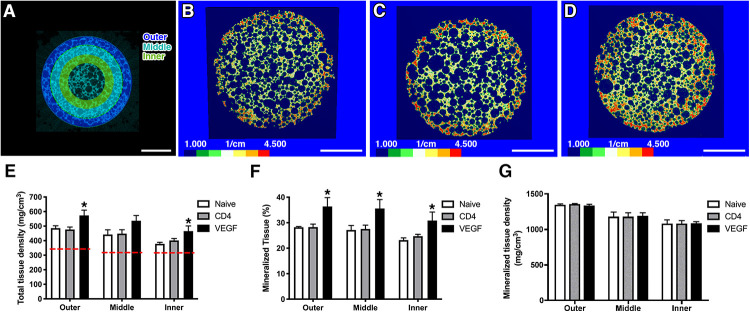
(A) For μ-CT analysis, 3 concentric sections, each 1.5-mm deep, were designed in order to distinguish an outer, middle and inner layer (size bar = 5 mm). (B–D) Representative images of constructs containing naïve rBMSC (B), CD4- (C) and VEGF-expressing rBMSC (D), color-coded according to tissue density (Houndsfield units, HU) (size bar = 5 mm); (E–G) Quantification of total tissue density (E), percentage of mineralized tissue (F) and density of mineralized tissue (G) in the three concentric layers defined in panel (A) (n = 4, *p < 0.05). The red dashed lines in (E) represent the density values of empty scaffolds implanted without any cells.